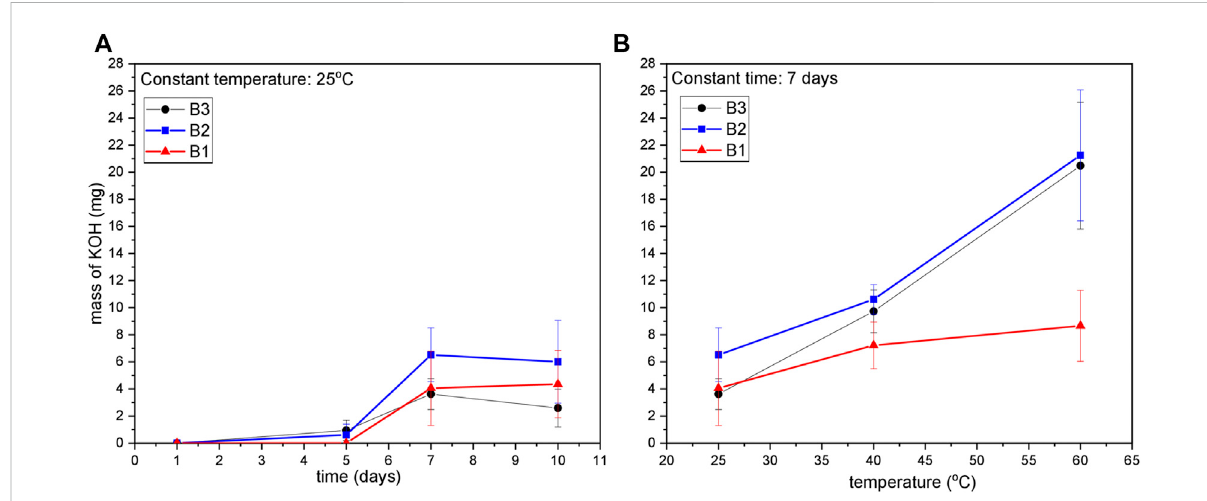
Titration result for KOH residuereleased fromthree different ZABvariants after their exposure to: (A) Constant temperature of 25 ° C and varying exposure time, (B) Constant exposure duration of 7 days with varying temperature level.